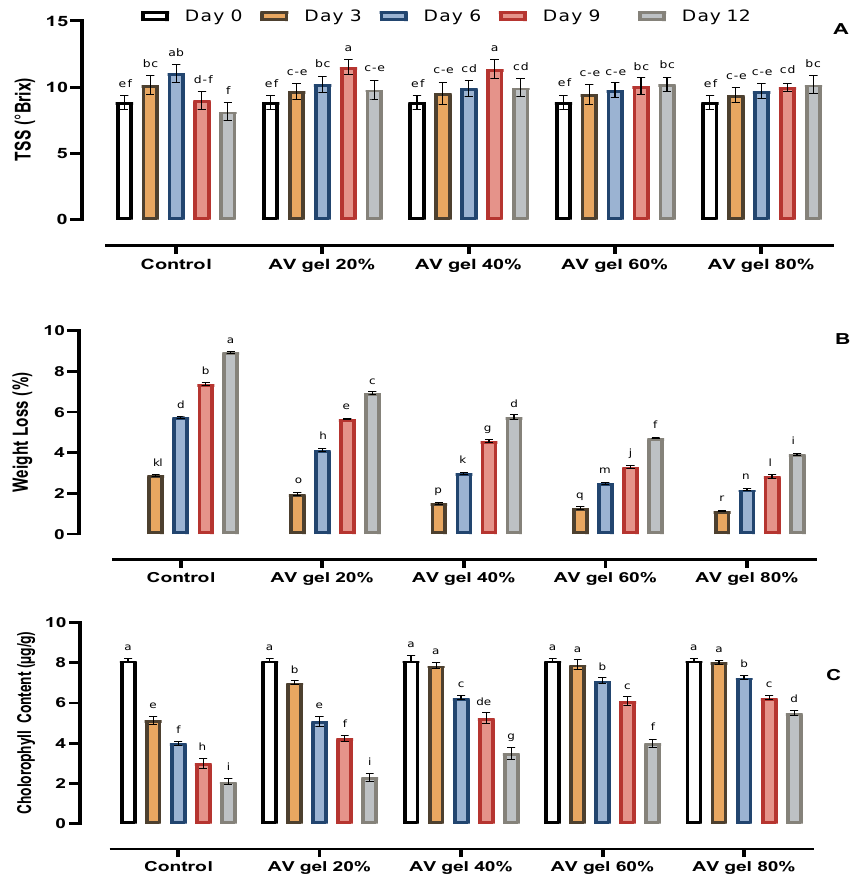
Figure 2. Result of AV gel coating on total soluble solids (TSS). ( A ), physiological weight loss ( B ), and chlorophyll content ( C ) in guava fruit. Standard error shown by vertical bars; each value represents the mean of three replicates. Different letters on the top of the bars indicate significant differences ( p ≤ 0.05).